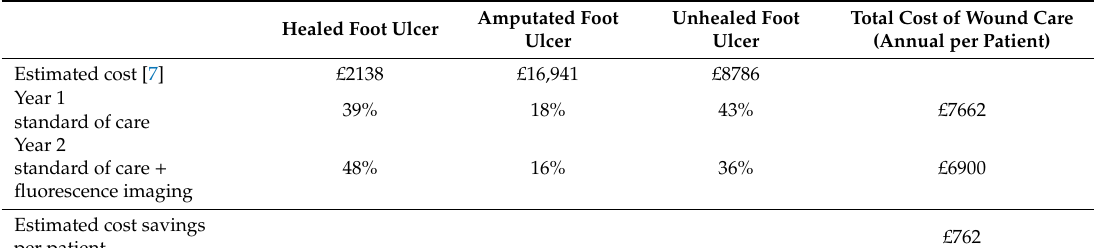
Table 3. Estimated annual total cost of wound care before (Year 1) and after (Year 2) implementation of the fluorescence imaging